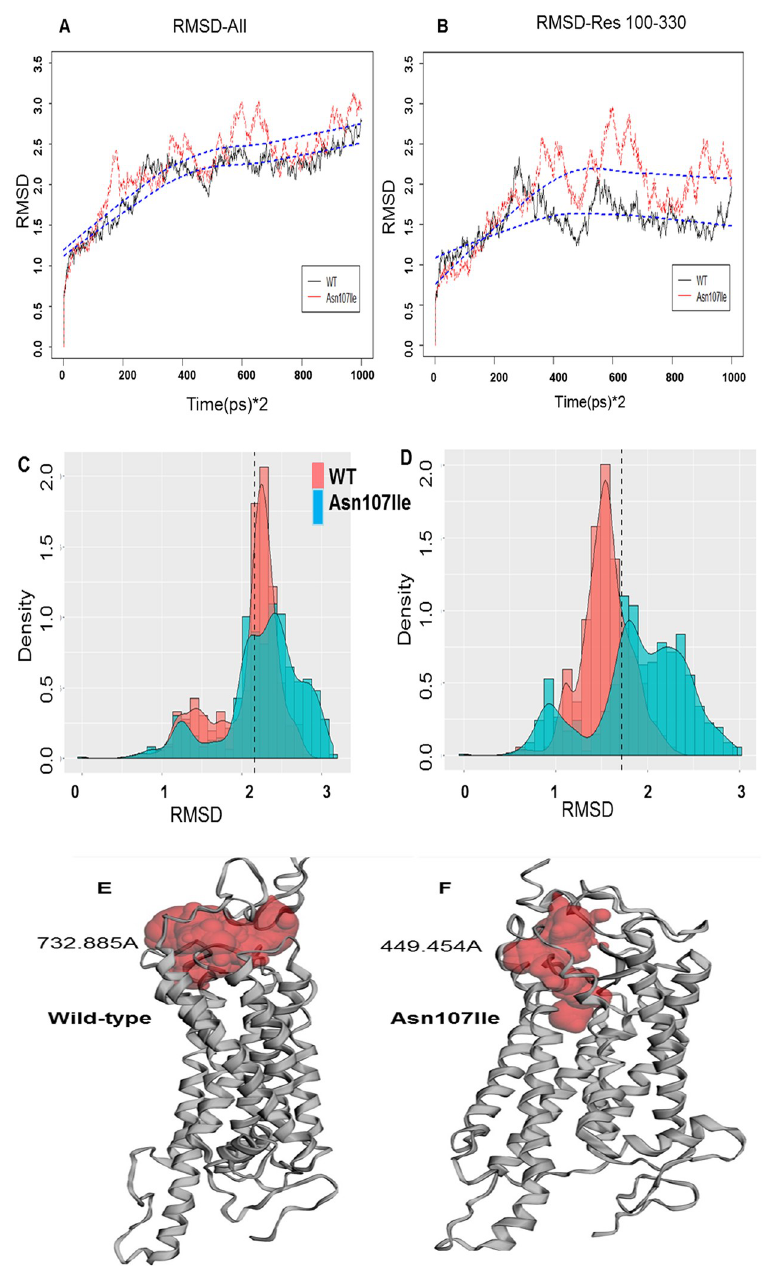
Fig 5. The root means squared difference (RMSD) of both WT and Asn107Ile in (A) all residues, and (B) residues 100–300 for each frame (each frame is 2 ps of a simulation). There is a clear divergence between the two structures when comparing residues 100–330. (C) RMSD Histogram for NPRS1 WT, and NPRS1 Asn107Ile obtained during the final 2 ns of the simulation. (D) The changes in RMSD distributions s more noticeable when isolating residues 100– 330. (E) Molecular structure (gray) of E. wild-type and (F) Asn107Ile variant NPSR1 obtained by molecular simulation with the pocket calculated by CASTp (red). The pocket-size is 732.885 A for WT and 449.454 for